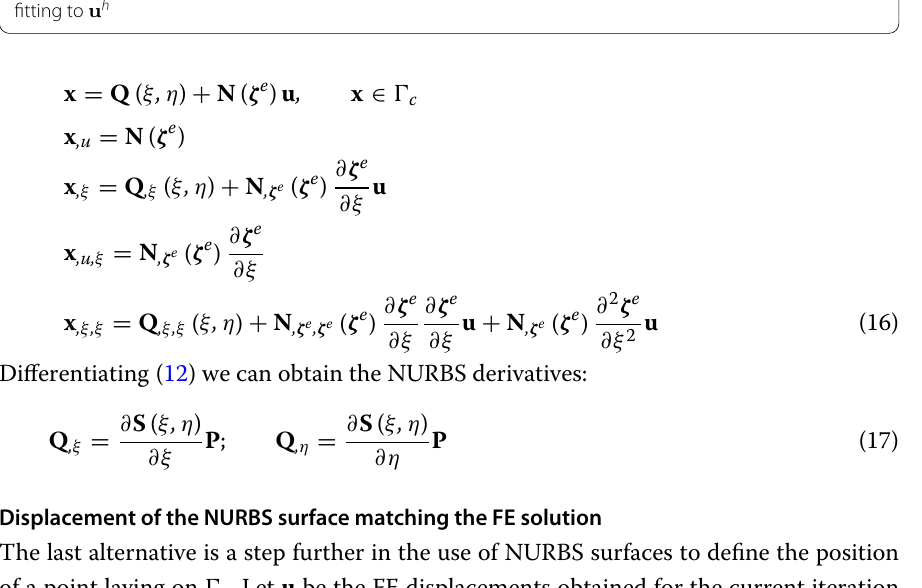
Fig. 6 Example of NURBS fitting to the FE solution. a NURBS definition of (cid:3) c . b FE solution u h . c